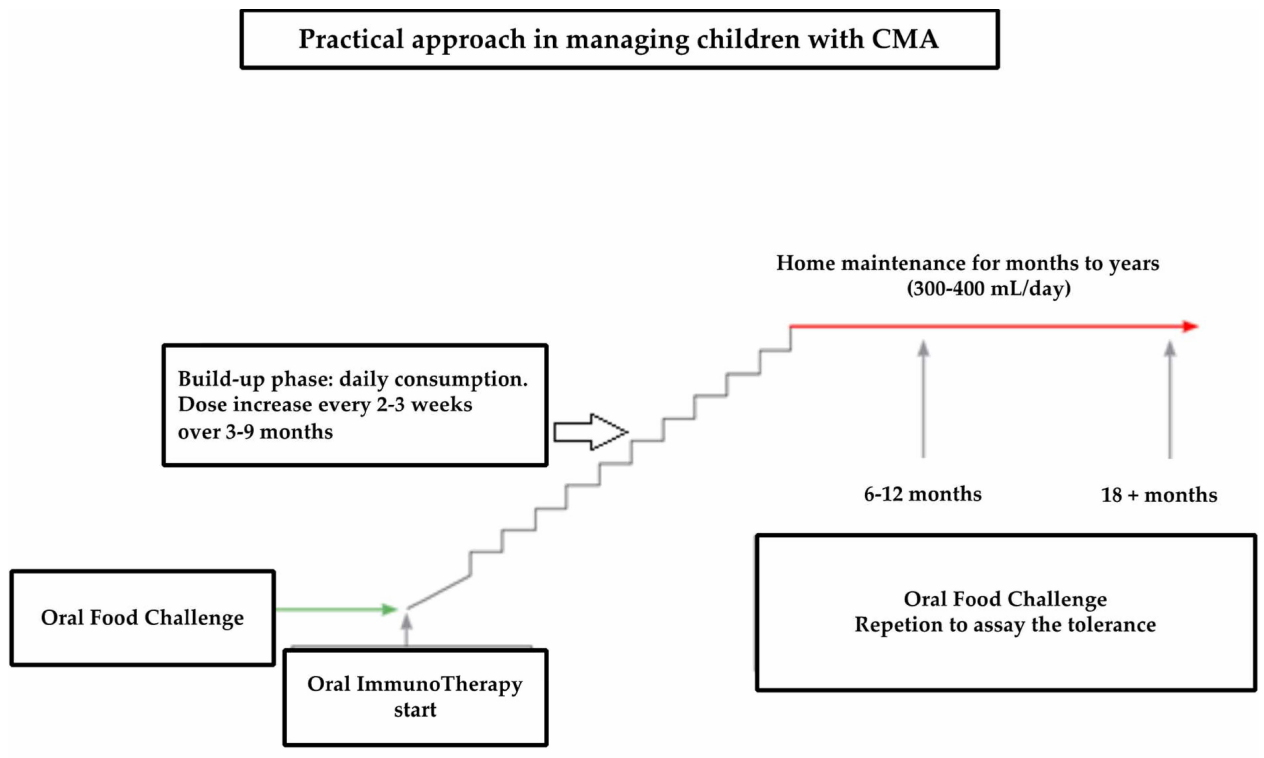
Figure 3. Practical approach in managing